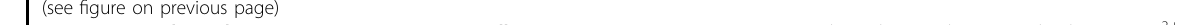
Fig. 3 TRPM8 channel activity in RWPE-1 prostate cells. a Representative images (upper panels) and traces (lower panels) showing [Ca 2 + ] i changes under control solution (CTR) or upon perfusion with menthol (1 mM), WS-12 (1 μ M), or icilin (10 μ M) on RWPE-1 cells. Time of drugs exposure is indicated by the bar on top of the traces. Quanti fi cation of [Ca 2 + ] i peaks measured upon perfusion with TRPM8 activators is reported on the right panel ( n = number of analyzed cells). The inset graph indicates the quanti fi cation of the total % of cells responsive to tested drugs. b Representative images (left panels) and traces (middle panels) showing [Ca 2 + ] i under control solution (CTR), upon perfusion with menthol (1 mM), WS-12 (1 μ M), or icilin (10 μ M), or after drugs washout on RWPE-1 M8 cells. Time of drugs exposure is indicated by the bar on top of the traces. Quanti fi cation of the [Ca 2 + ] i peaks measured upon perfusion with TRPM8 activators is reported on the right panel ( n = number of analyzed cells). The inset graph indicates the percentage of cells responsive to the drugs tested. c Left panel, representative traces of currents evoked by a 100 ms voltage ramp ranging from − 100 mV to + 100 mV applied every 4 s in control solution (CTL), during application of menthol (500 μ M) or after drug washout (W). Right panel, representative time-courses of currents recorded at + 80 mV (blue symbols) or − 80 mV (red symbols) in single RWPE-1 M8 cells upon exposure to menthol (500 μ M). Time of menthol exposure is indicated by the line on top of the traces. d Western blotting analysis with two independent antibodies (D21E4 and 22B1) showing CaMKII α activation (phosphorylation of Thr286) following WS-12 treatment of RWPE-1 M8 cells. Cells treated with ionomycin were used as positive control for calcium dependent CaMKII α phosphorylation. Error bars, mean ± SEM. Experiments were performed in at least three experimental sessions; data were analyzed using a two-tailed Student ’ s t -test. * P ≤